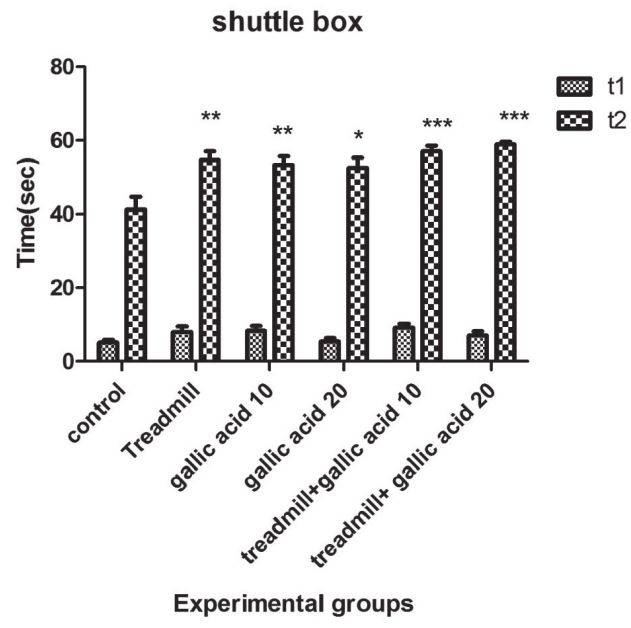
FIGURE 1 - The effects of gallic acid and physical exercise, alone and combined, on initial latency and secondary latency in passive avoidance memory test. * =( p <0.05); ** = ( p <0.01); *** = ( p